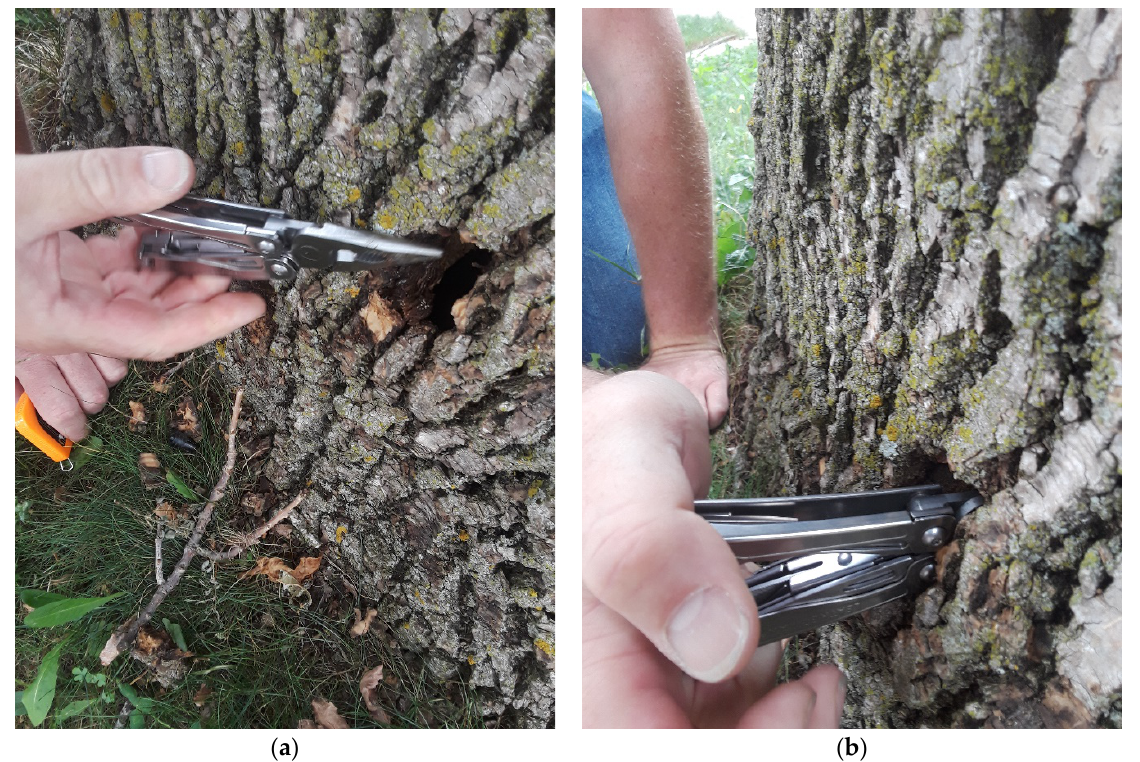
Figure A5. ( a ) Example wound partially obscured by bark; ( b ) Example wound partially obscured by bark with tool inserted.